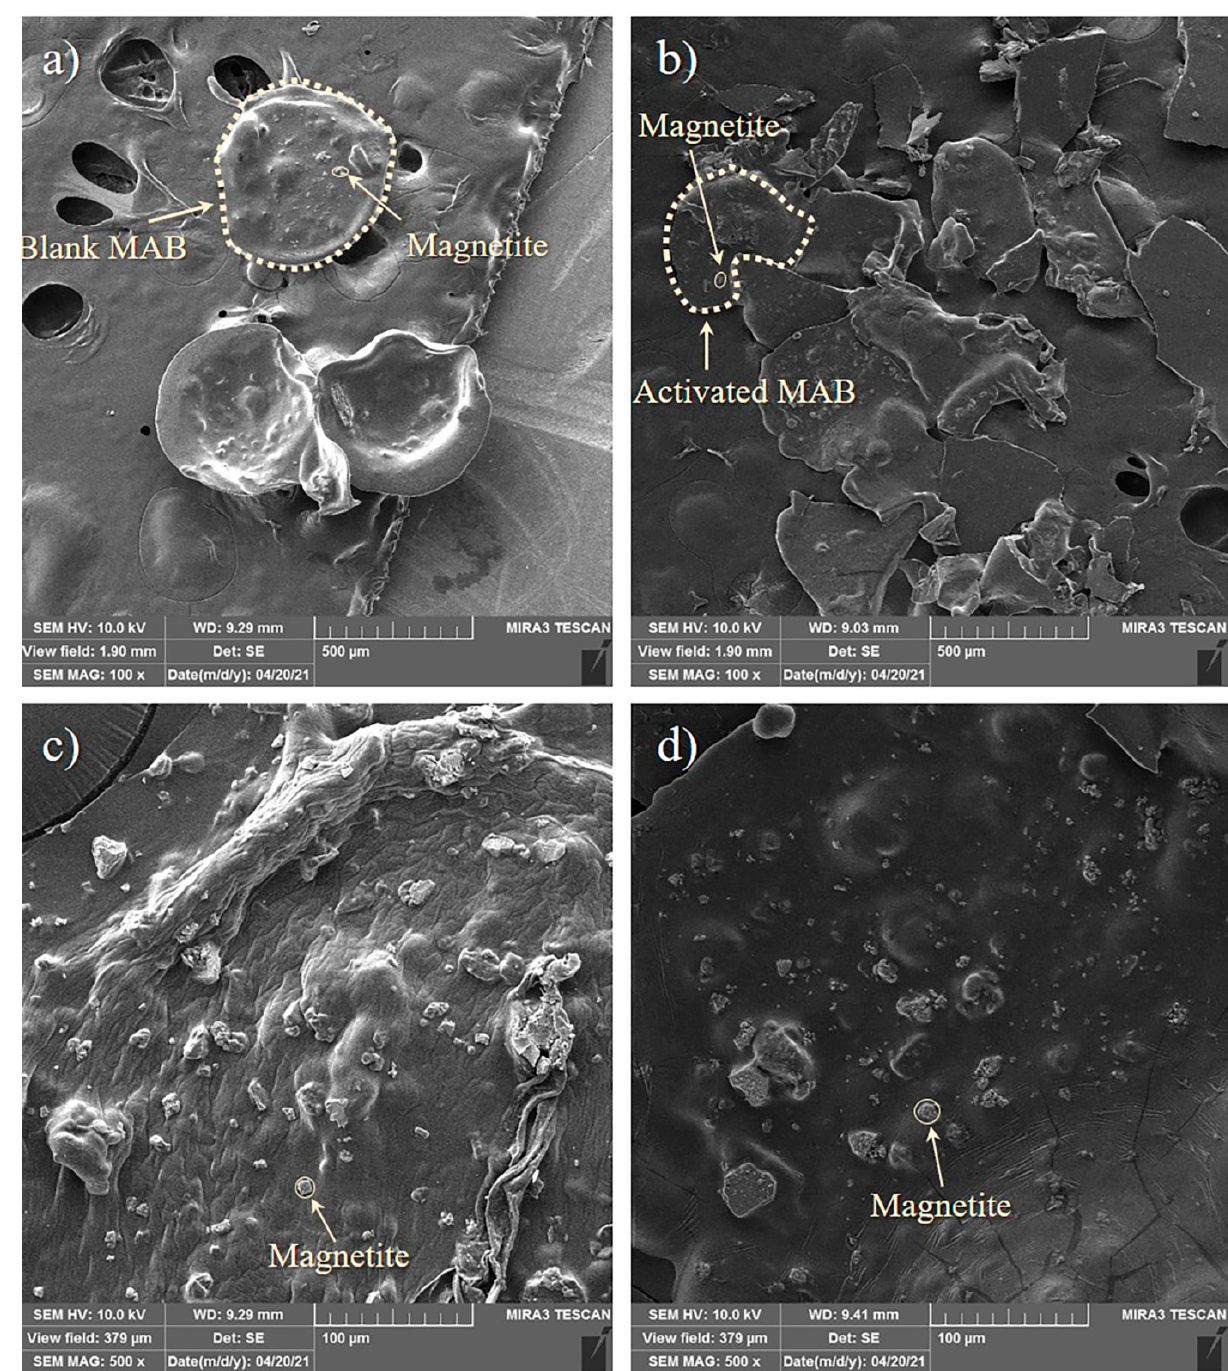
Figure 2. SEM micrographs of ( a ) blank MABs at 100× magnification; ( b ) activated HRP-MABs at 100× magnification; ( c ) External surface of blank MABs at 500× magnification; ( d ) External surface of activated HRP-MABs at 500× magnification.